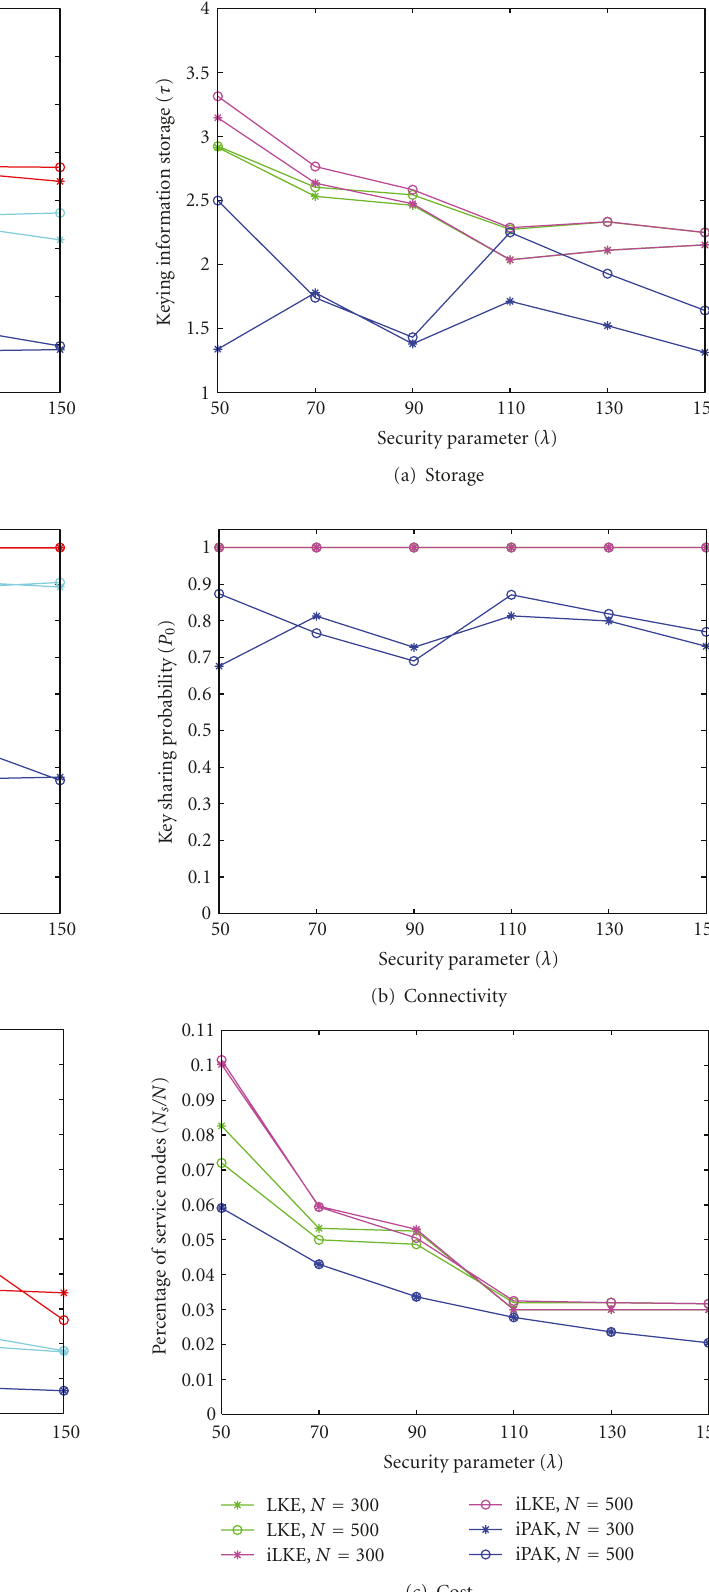
Figure 4: Test 1. iPAK versus SBK (iPAK: ρ = 1, N T Comparison on storage, connectivity, and cost.